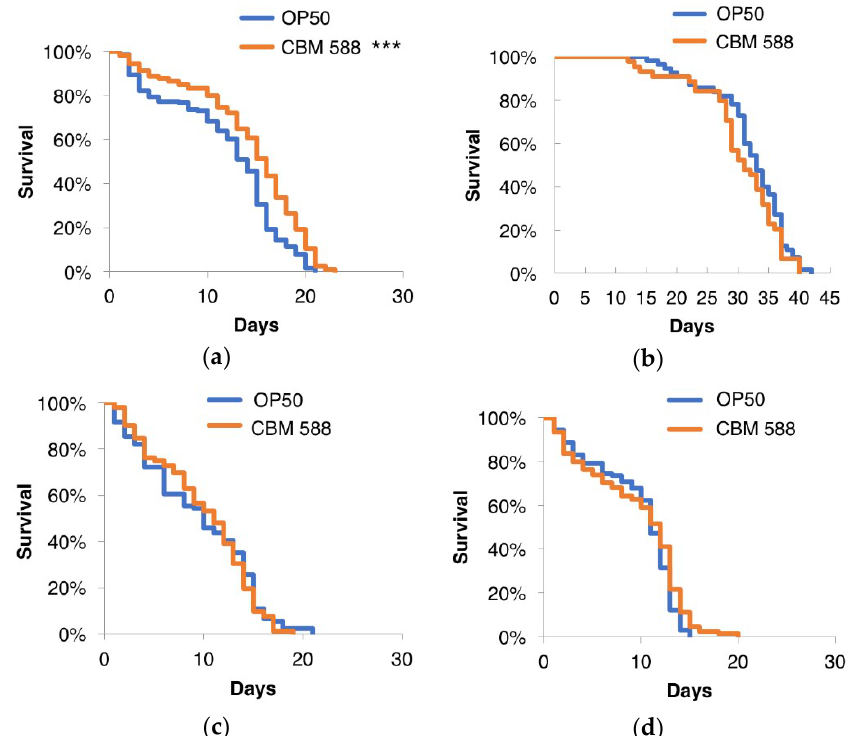
Figure 6. Effects of CBM 588 on the lifespan of C. elegans loss-of-function mutants. Survival curves of the wild-type animals ( a ) and the daf-2 ( b ), daf-16 ( c ), and skn-1 mutants ( d ). CBM 588 failed to extend the lifespan of these mutants. The survival curves were compared with those of worms fed OP50. *** Statistical significance at p < 0.001, log-rank test. Detailed lifespan data and statistics are provided in